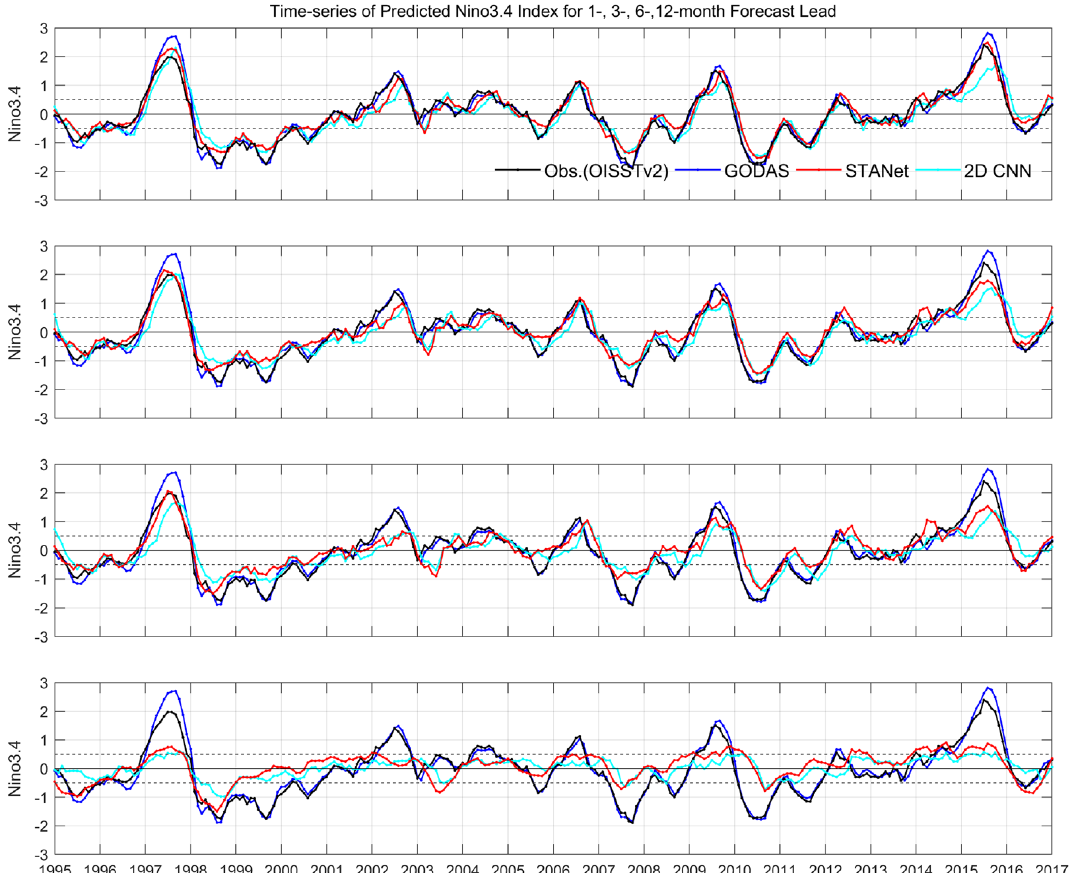
Figure 4. Time series of predicted Nino3.4 index from the proposed STANet with observation (OISST v2), GODAS, and SOTA 2D CNN result for test period of 1996–2016. From top to bottom, the time series with forecast lead time of 1-, 3-, 6-, and 12-month are shown,